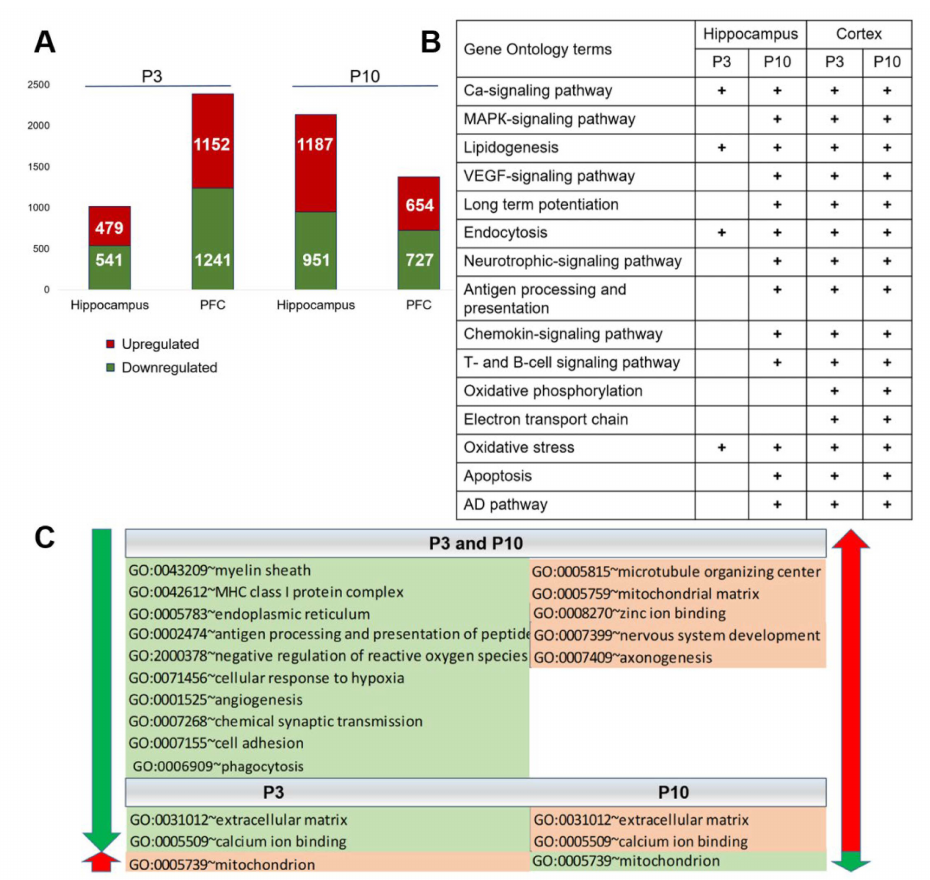
Figure 1. Differential expression of genes: the effect of the genotype (strain). ( A ) The number of DEGs in the PFC and hippocampus of 3- and 10-day-old OXYS rats compared to age-matched Wistar rats. The numbers of DEGs are marked red if upregulated and green if downregulated. ( B ) Pathways (according to KEGG and Wiki pathways) that undergo changes in OXYS rats, as compared to age- matched Wistar rats. ( C ) The most significant GO terms in the PFC and hippocampus of OXYS rats according to DAVID are highlighted in red if upregulated and in green if